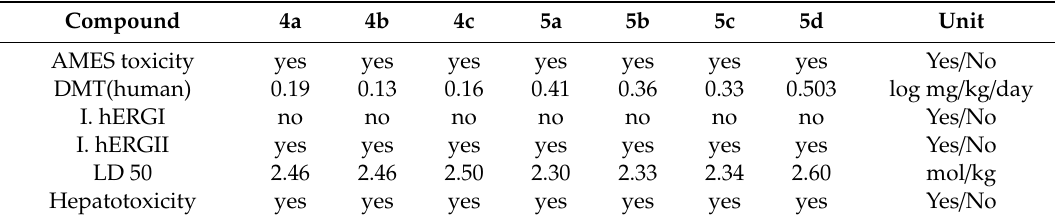
Table 7. Toxicity